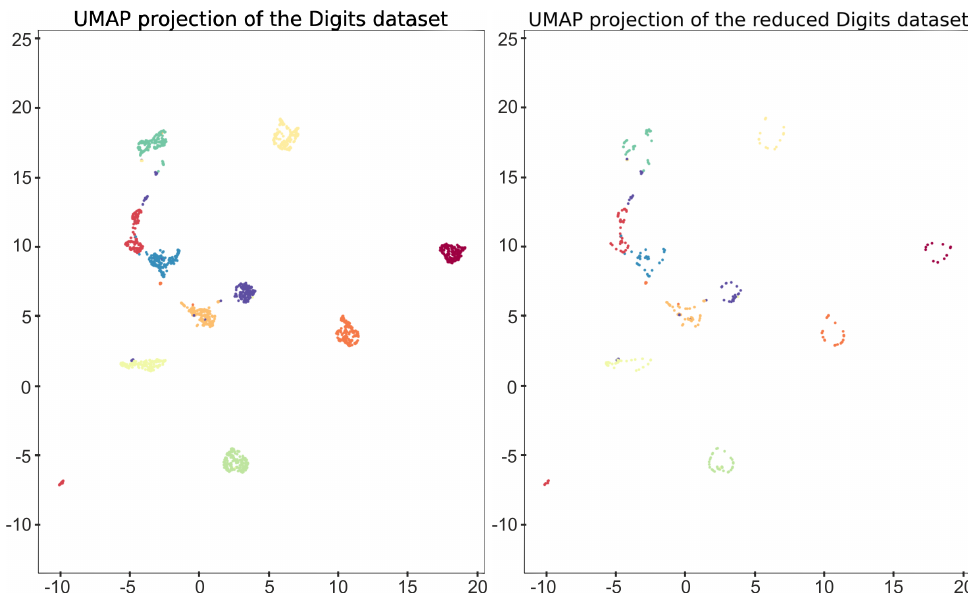
Figure 4. Some of the 1797 images used in the experiment. The images are labeled from 0 to 9 in a natural way. Each image is grey-scaled and has 8 × 8 pixels, so it can be represented as a point in R 64 . In order to visualize such 1797 64-dimensional points, R 64 has been projected into R 2 using the UMAP algorithm. Figure 5 shows the projection on R 2 of the 1797 images.